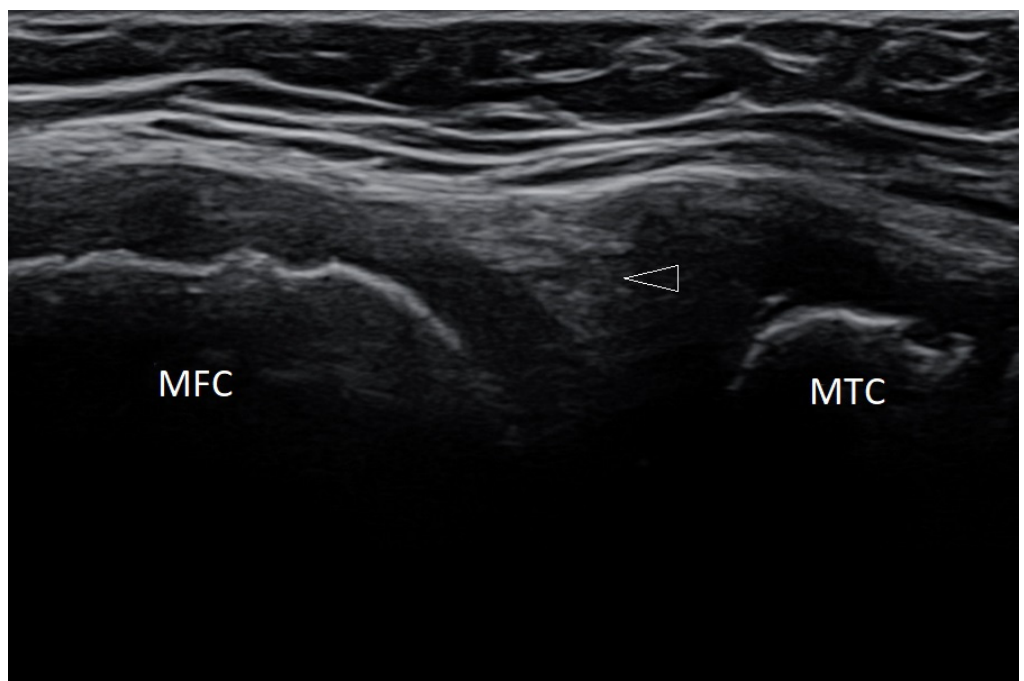
Figure 4. Longitudinal scan of the posterior-medial knee of a 10-year-old boy. MFC—medial femoral condyle; MTC—medial tibia; arrowhead—hypoechoic focus in the posterior part of the medial meniscus, which should be considered normal (physiologically).